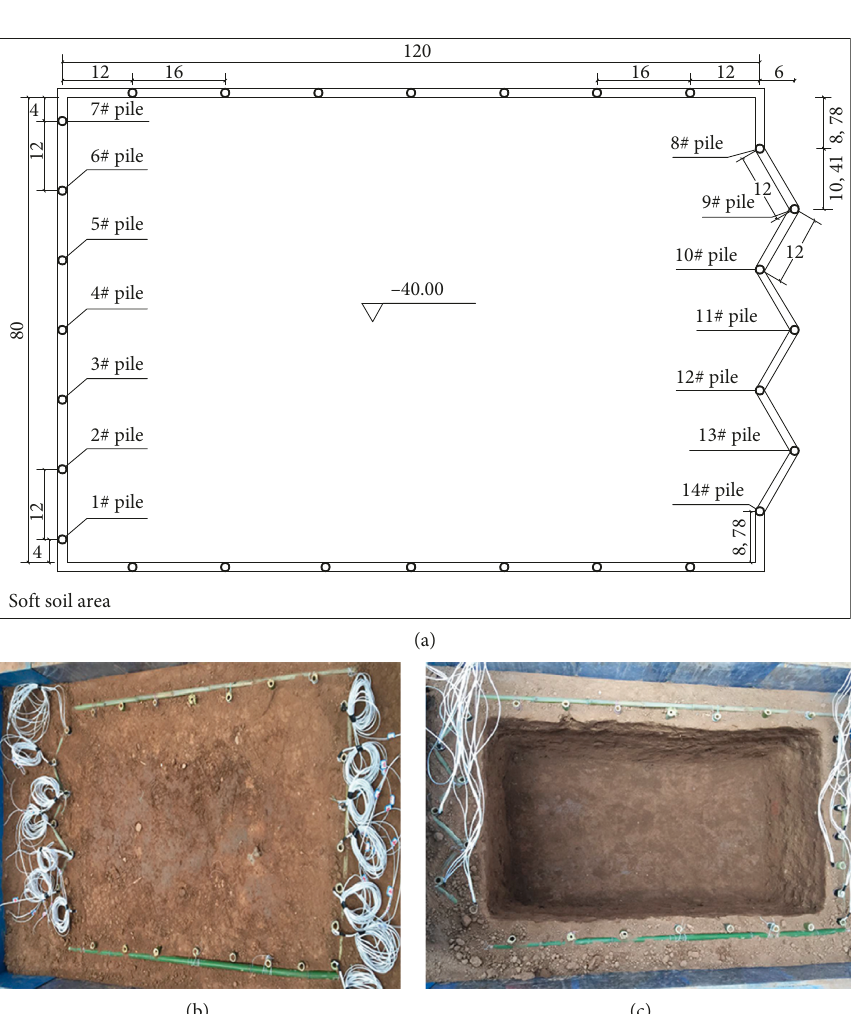
Figure 5: Foundation pit model. (a) Foundation pit plan. (b) Before excavation. (c) After